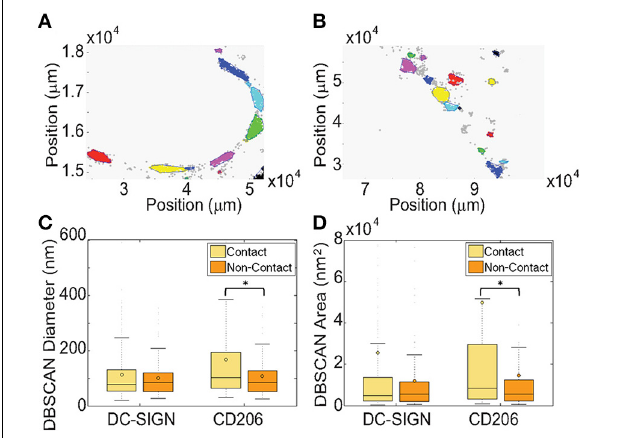
FIGURE 5 | DBSCAN statistical analysis of clustering and local density in fungal contact regions on dendritic cells. (A) A representative map of clusters of CD206 identified using DBSCAN in a zymosan contact ROI on a dendritic cell with a zymosan particle bound. Different colors represent independent clusters identified by the algorithm. (B) A representative map of clusters of CD206 in a non-contact ROI on the same cell as in (A) . Results are shown for DBSCAN run with an epsilon value of 30nm and 10 as a minimum number of points per cluster. (C) Box and whisker plot, as defined in the legend to Figure 4 , of the cluster diameters from DBSCAN analysis. (D) Box and whisker plot of the cluster areas from DBSCAN analysis. Results were calculated from 11 and 8 pairs of zymosan contact regions and non-contact regions for DC-SIGN and CD206, respectively. Box and whisker plots were scaled for visualization of the mean and median values, resulting in some larger outliers to be omitted from the plots. The maximum % of outliers not displayed due to scaling is 10.7% of the total dataset. ∗ Indicates that the difference between the value and the value